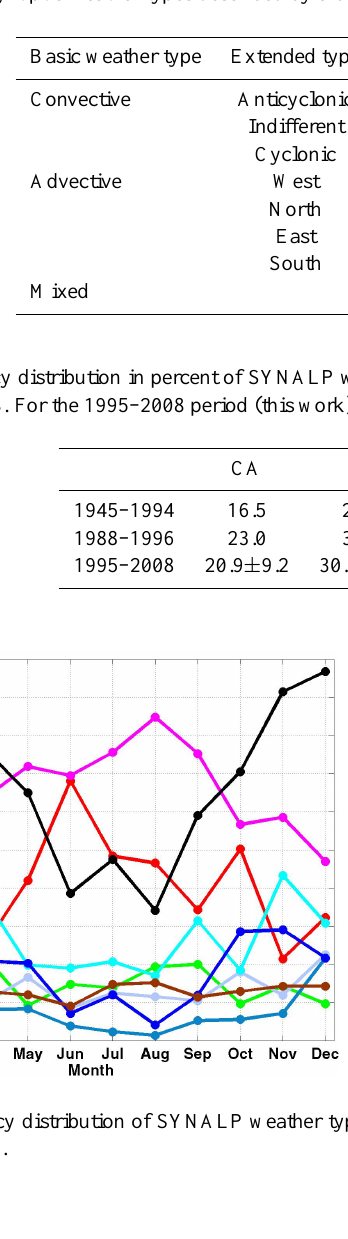
Table 1. The SYNALP synoptic weather types described by 3 basic types, 8 extended types, and by the dominant synoptic scale motion.